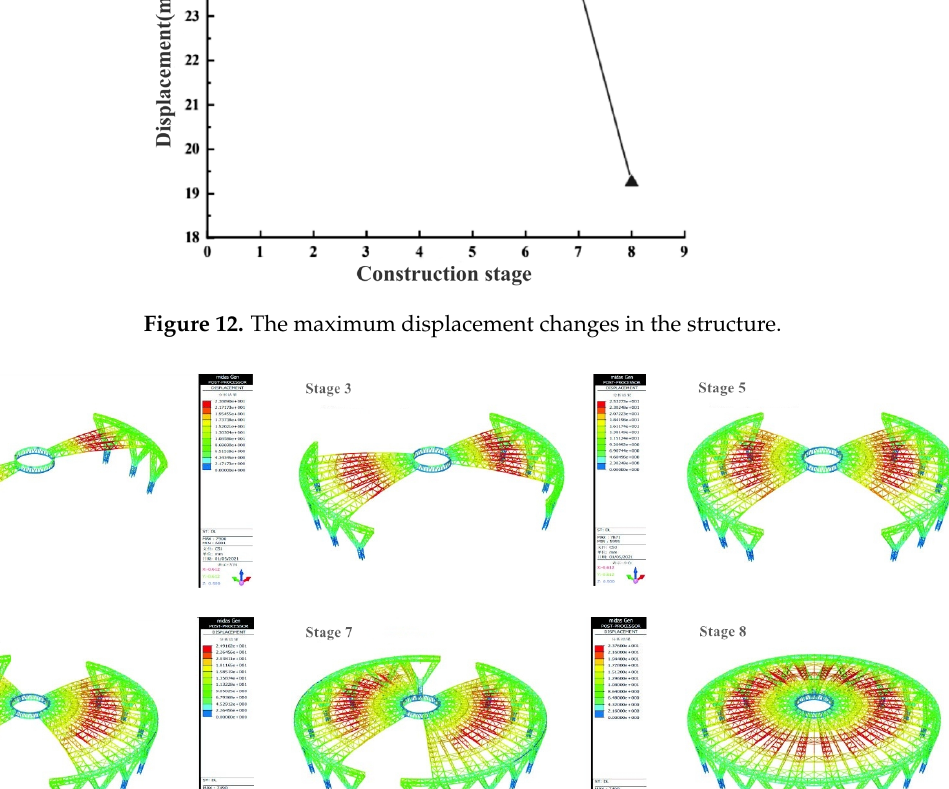
Figure 14. Displacement variation diagram of a control node in the midspan of each unit. Figure 15. Stress change curve of the first unit control bar.